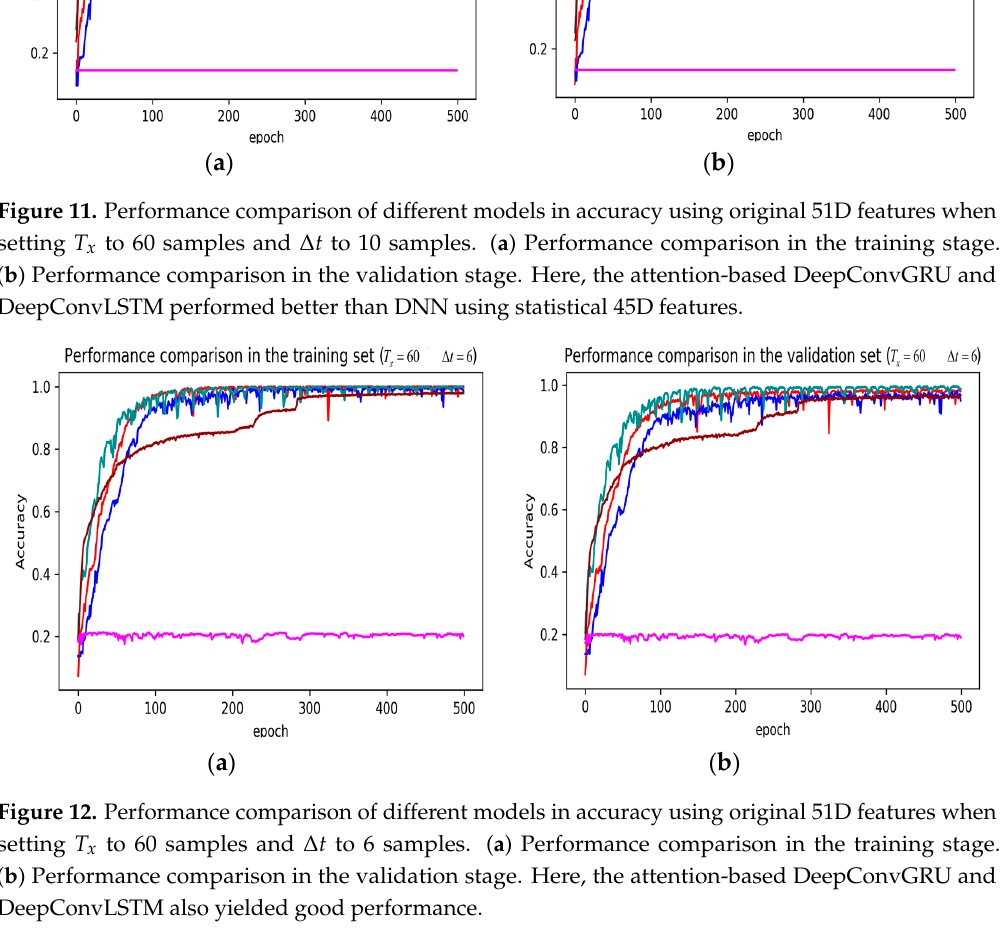
Table 4. Driving behavior identification for different methods when setting to 10 samples.